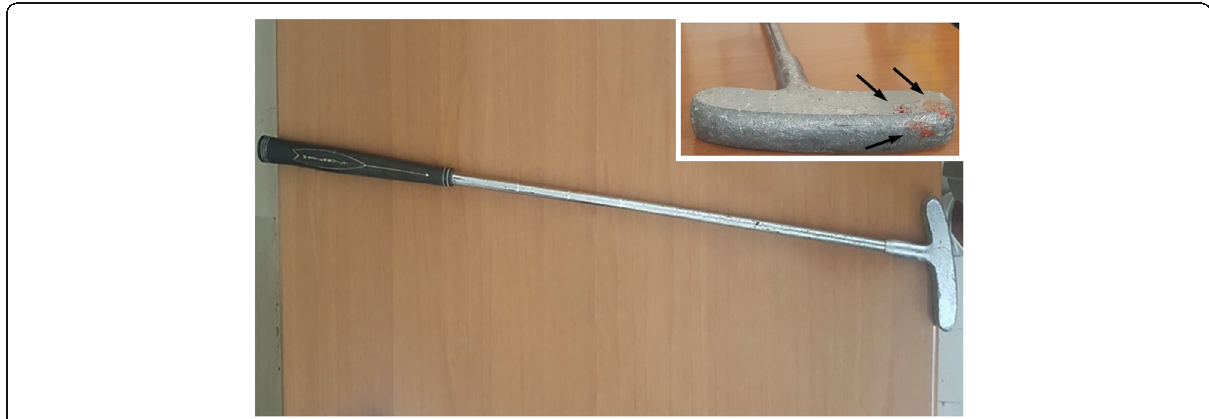
Fig. 2 The golf club used by the victim to attack the neighbor. It was concealed by the relatives but it was discovered by the K-9 unit. In the inset, the presence of biological traces (blood) is